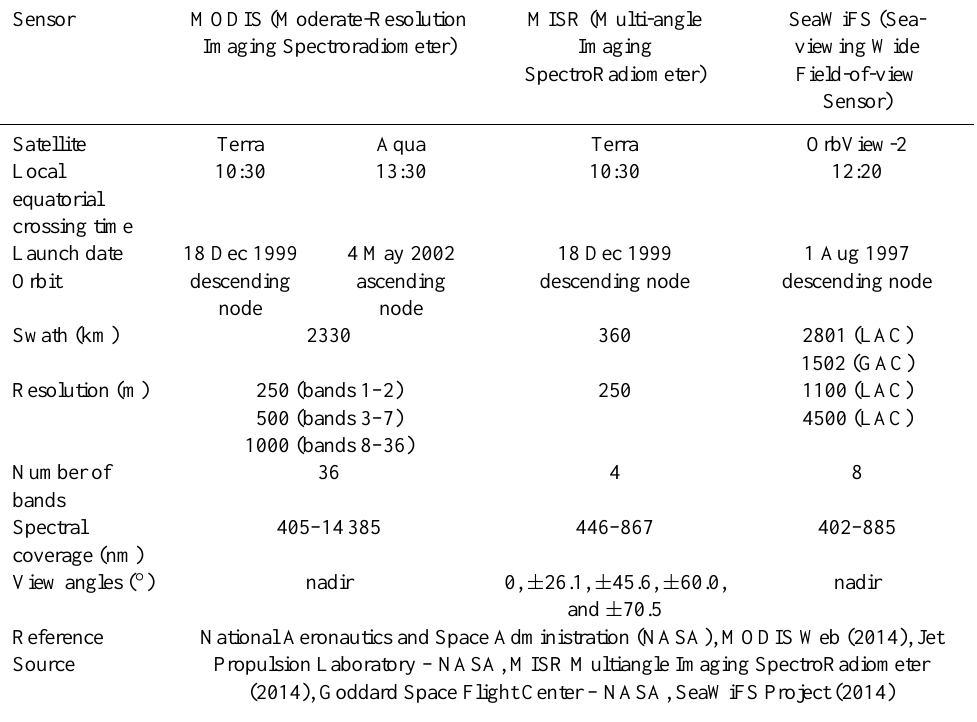
Table 1. The characteristics of the instruments and their corresponding platforms (i.e. MODIS-Terra, MISR-Terra, SeaWIFS-OrbView-2, and MODIS-Aqua). The calibration approach/status, aerosol retrieval accuracy, research period, and data set used in this study are summarized for each